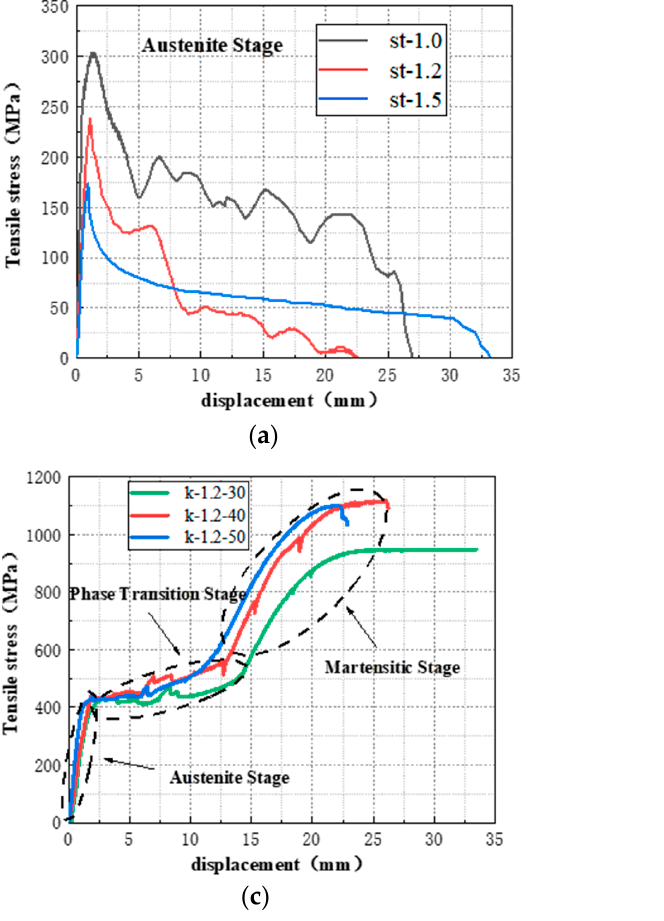
Figure 9. The pullout load-displacement-stress curves of test specimens. ( a ) The first group; ( b ) The second group; ( c ) The third group; ( d ) The fourth group. Table 4. The main pullout mechanical parameters of test specimens a .